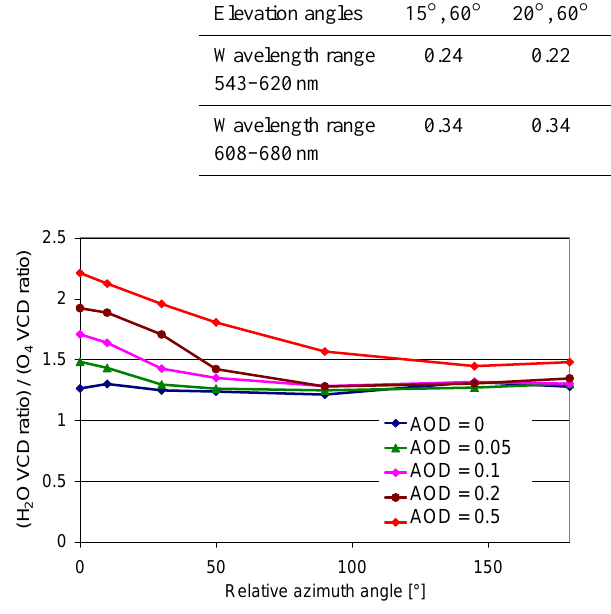
Fig. 5. Ratio of the relative deviation of the geometric approxima- Fig. 5 Ratio of the relative deviation of the geometric approximation for H 2 O and O 4 (see Fig. tion for H 2 O and O 4 (see Fig. 4 bottom). A value of 1.25 is used to 4 bottom). A value of 1.25 is used to correct the retrieved H 2 O VCDs (see text). correct the retrieved H 2 O VCDs (see